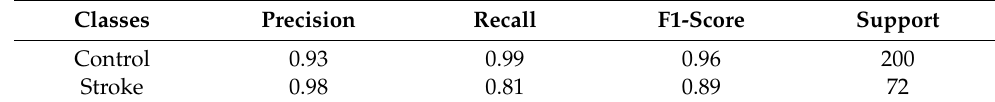
Table 5. Support Vector Machine model classification report.